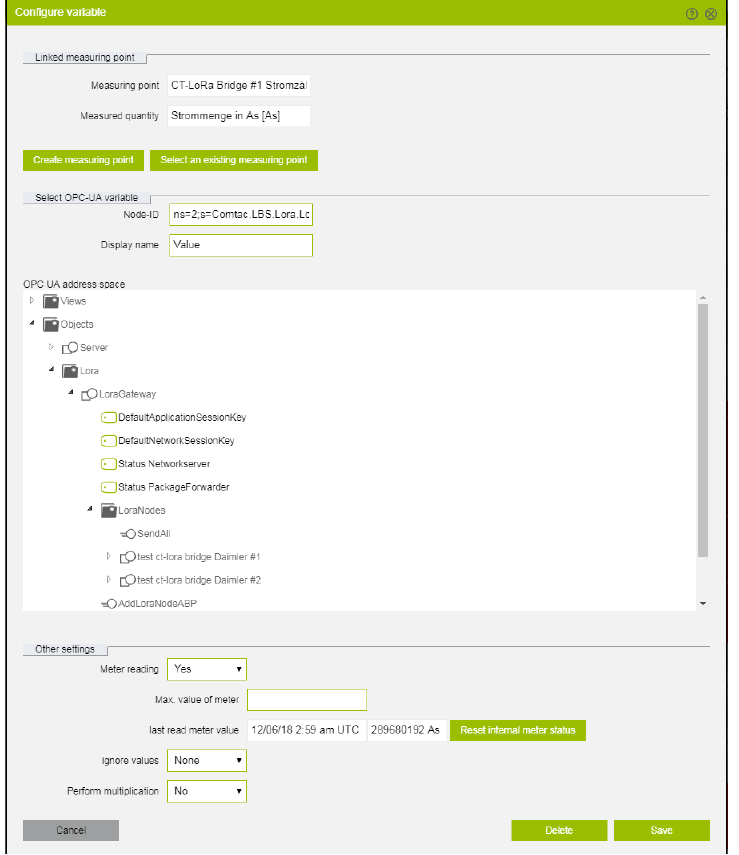
Figure 7. OPC UA client setup in the energy management system (EMS). Appl. Sci. 2018 , 8 , x FOR PEER REVIEW